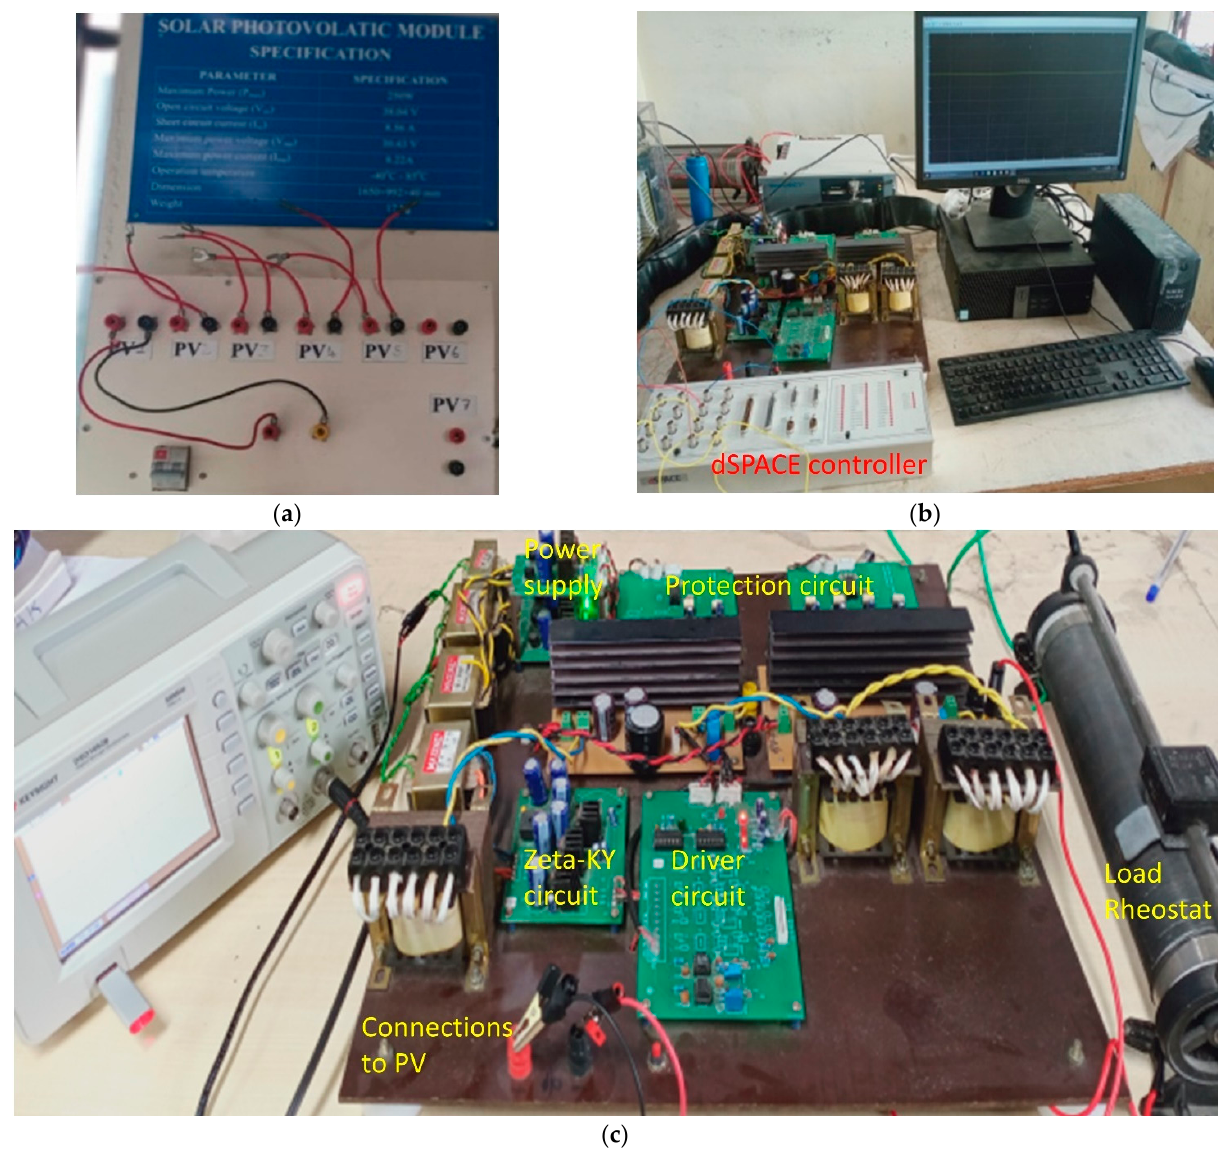
Figure 14. ( a ) PV panel of 250 W; ( b ) experimental set-up of the proposed converter with dSPACE controller; and ( c ) closer view of the converter. The dSPACE controller generated pulses to trigger switches S 1 , S 2, S 3, S 4. The gener- ated pulses from the controller were observed through the digital storage oscilloscope